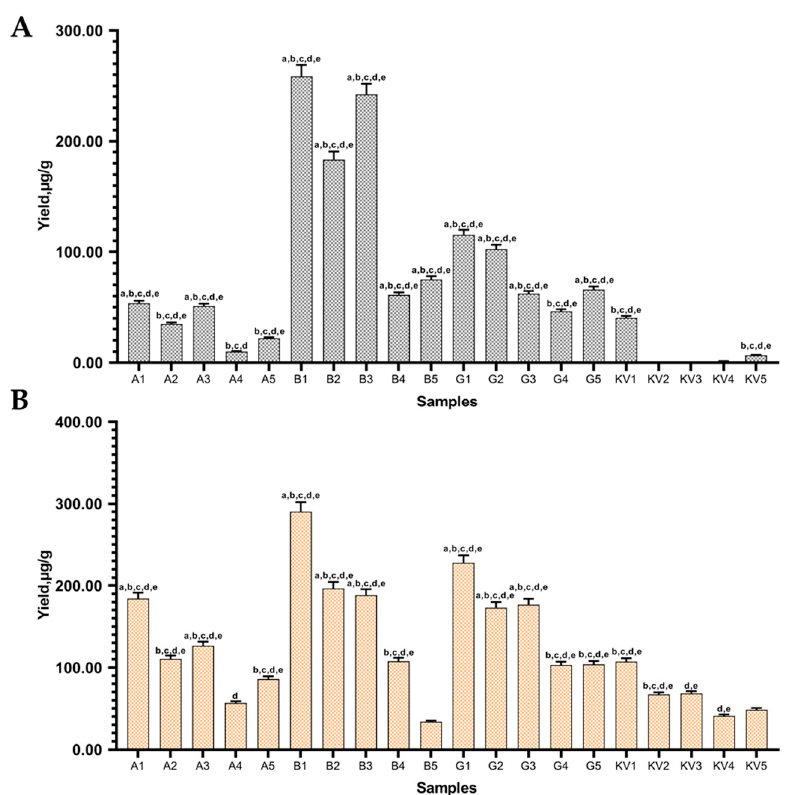
Figure 4. Quantitative yield of ( A ) genistein and ( B ) daidzein using excipients (1%). Control samples without excipients (KV1-5), samples with α -CD (A1-5), β -CD (B1-5), γ -CD (G1-5). a p < 0.05 vs. KV1, b p < 0.05 vs. KV2, c p < 0.05 vs. KV3, d p < 0.05 vs. KV4, e p < 0.05 vs. KV5. Sample codes are provided in Table 1.